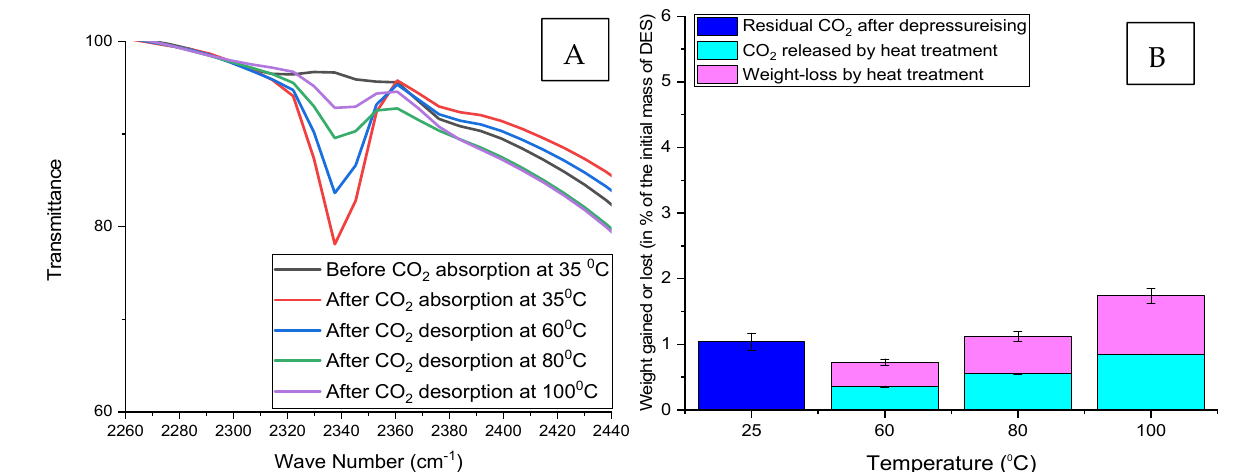
Figure 11. Regeneration of ChCl:LvAc (1:3:0) after CO 2 absorption at 25 °C. ( A ) Reduction in FTIR transmittance peak associated with the double carbonyl group with increasing regeneration temperature; ( B ) residual CO 2 after depressuri- sation, CO 2 released by heat treatment and weight loss after regeneration at different temperatures.